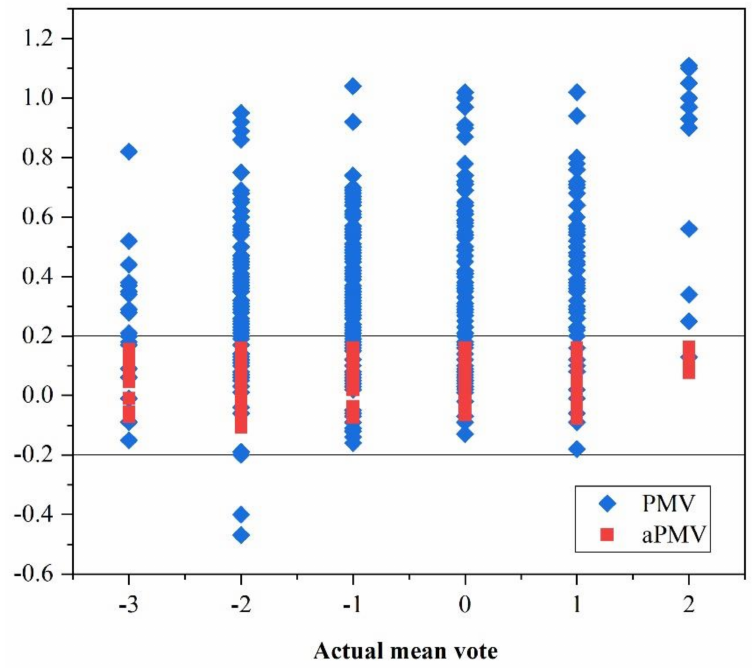
Figure 14. Comparison between adaptive predicted mean vote (aPMV) and predicted mean vote (PMV) versus actual mean vote (winter).